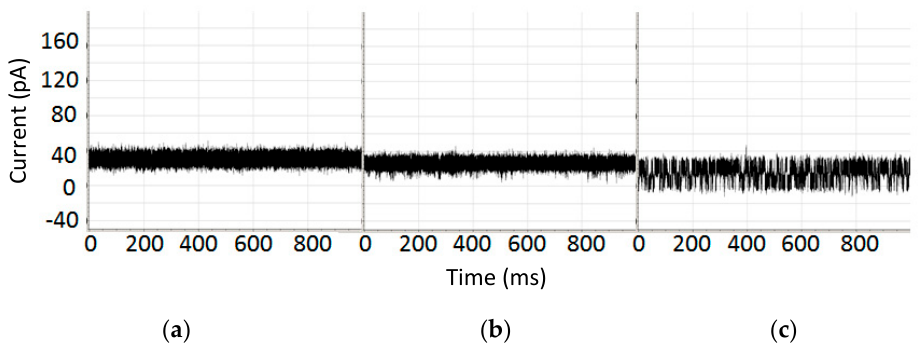
Figure 2. ( a ) Channel current blockade signal where the blockade is produced by 9GC DNA hairpin with 20 bp stem [19]; ( b ) Channel current blockade signal where the blockade is produced by 9GC 20 bp stem with magnetic bead attached; ( c ) Channel current blockade signal where the blockade is produced by c9GC 20 bp stem with magnetic bead attached and driven by a laser beam chopped at 4 Hz. Each graph shows the level of current in picoamps over time in milliseconds.